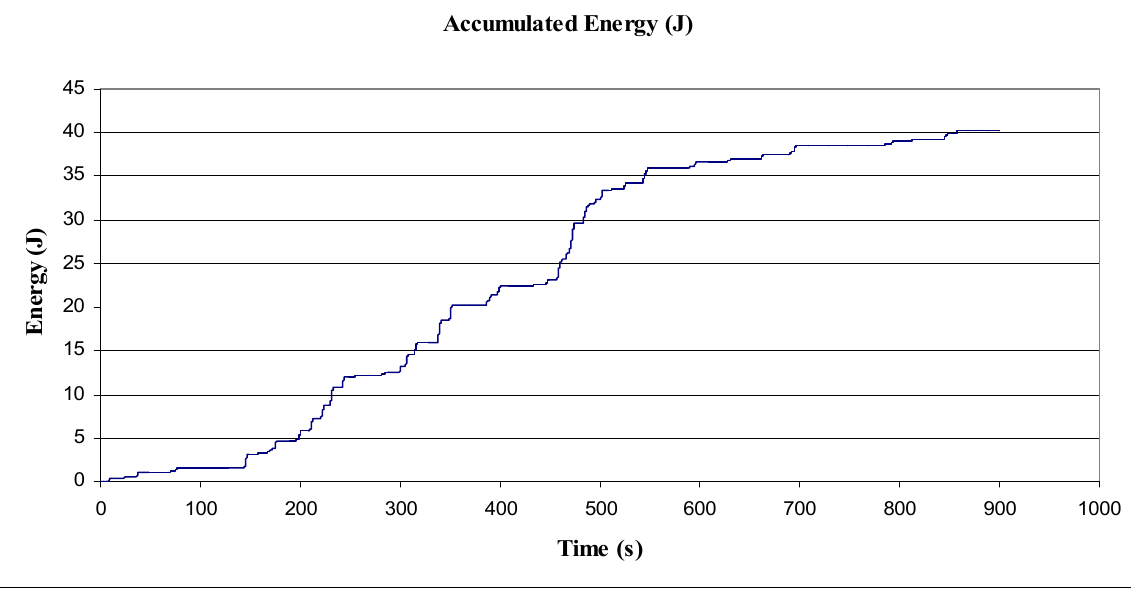
Figure 10. Accumulated Energy, E